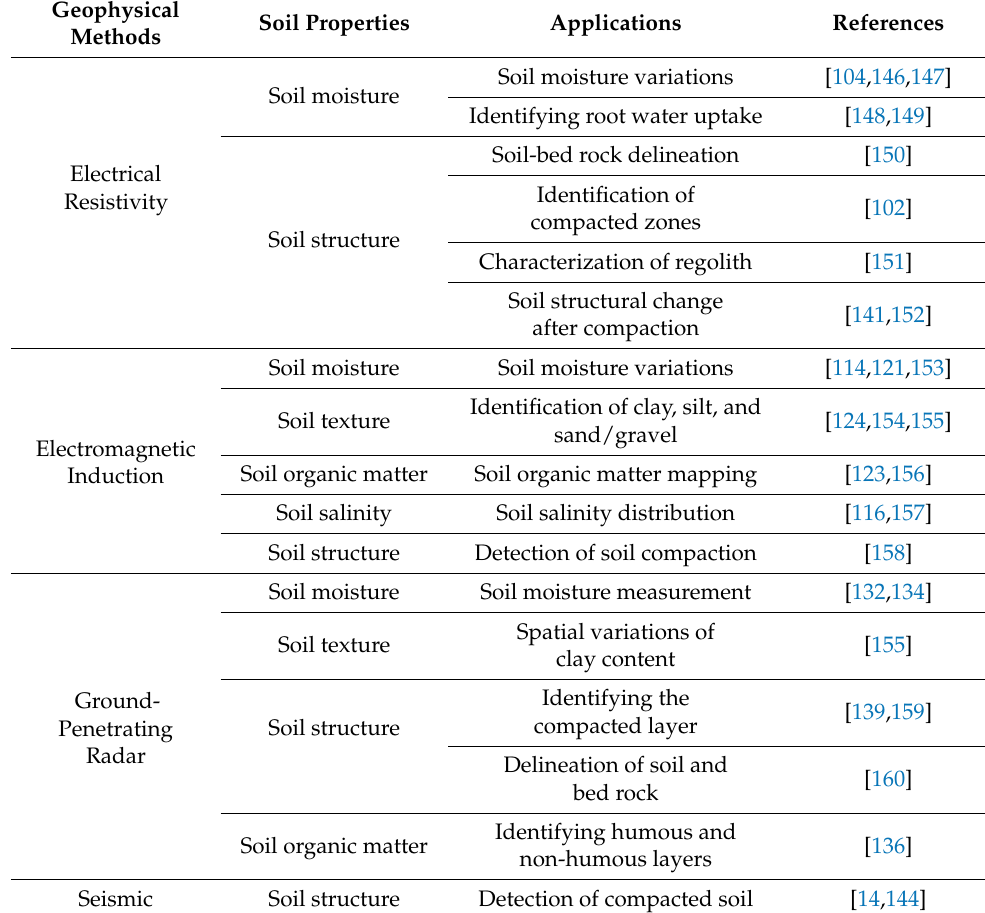
Table 2. The geophysical methods and their applications in agricultural soil